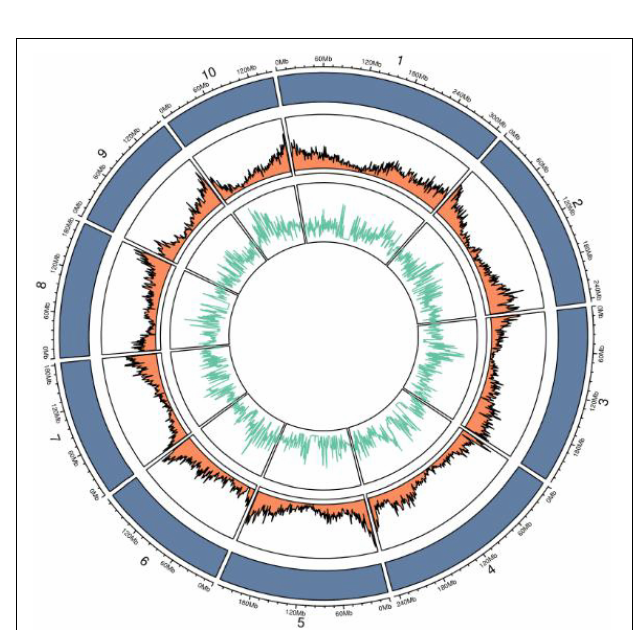
FIGURE 7 | Circos diagram of SNPs on different